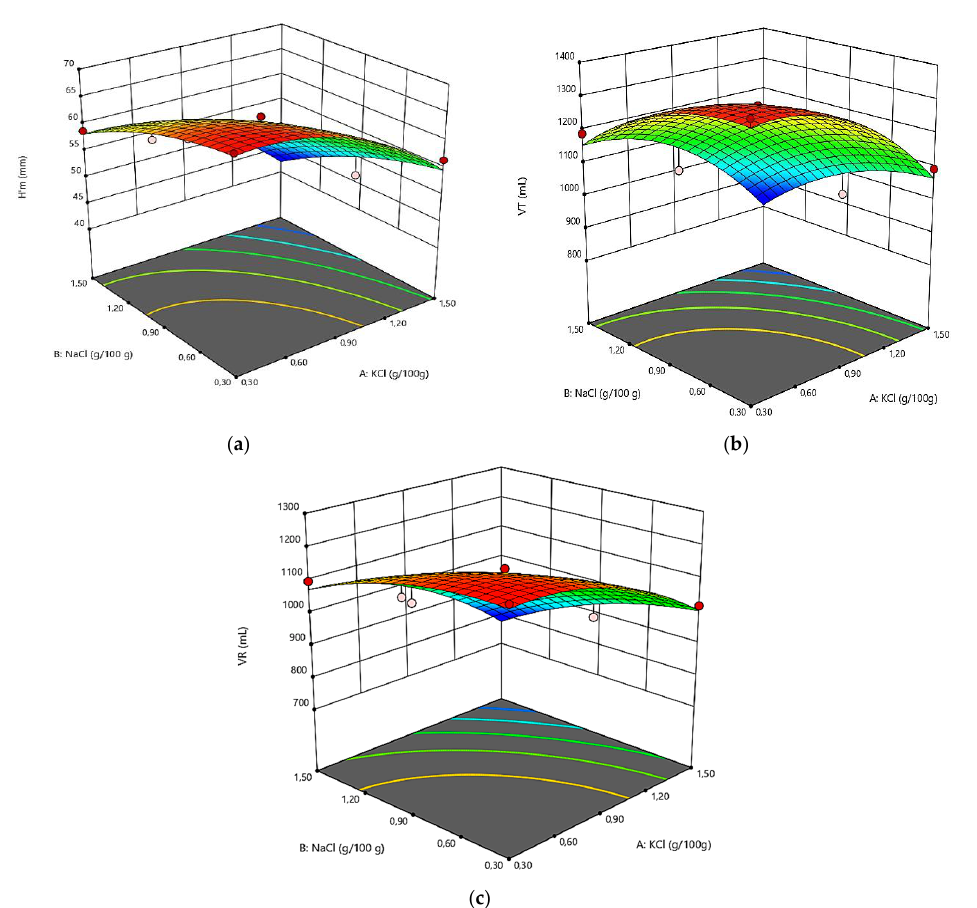
Figure 3. The graphical representations of the Rheofermentometer parameters: ( a ) maximum height of gaseous production (H’m); ( b ) total CO 2 volume production (VT); ( c ) volume of the gas retained in the dough at the end of the test (VR).